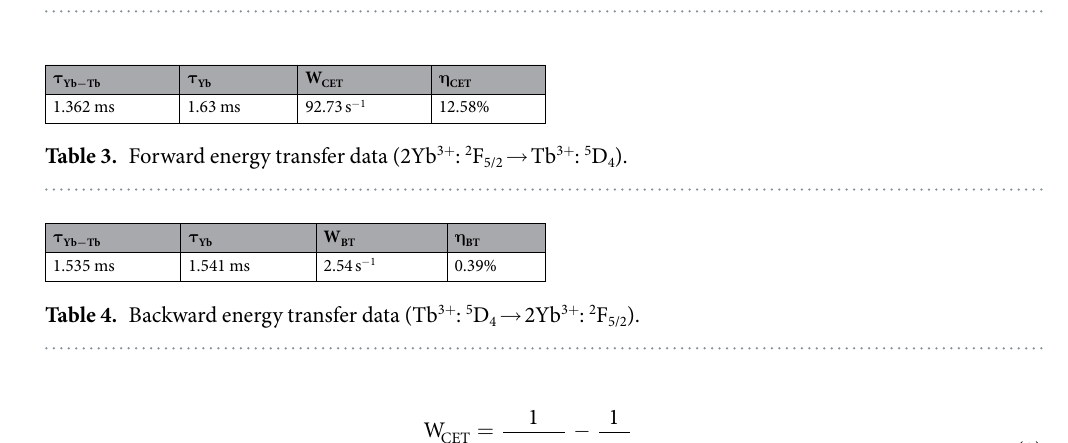
Table 2. Compositions of the samples doped with Yb 3 + or Tb 3 + ions.